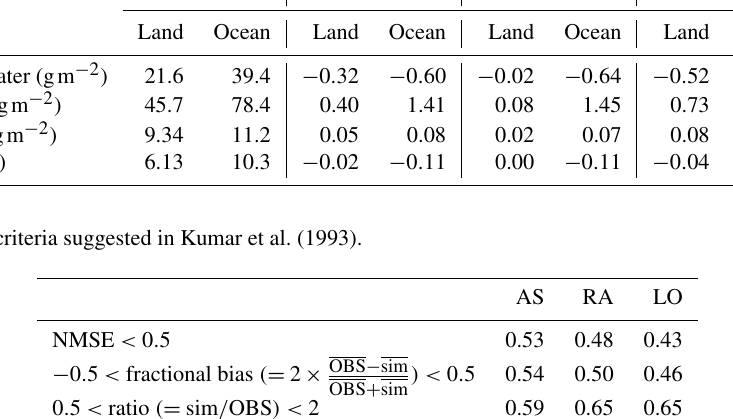
Table 2. Domain-averaged water budgets of AS and their differences from other simulations. The data are averaged from 00:00UTC on 15 May to 00:00UTC on 15 June. Rainwater in this study refers to the liquid phase of water that has a potential to become rainfall in the model. LWP stands for liquid water path, and IWP stands for ice water path. AS RA – AS LO – AS SA – AS Land Ocean Land